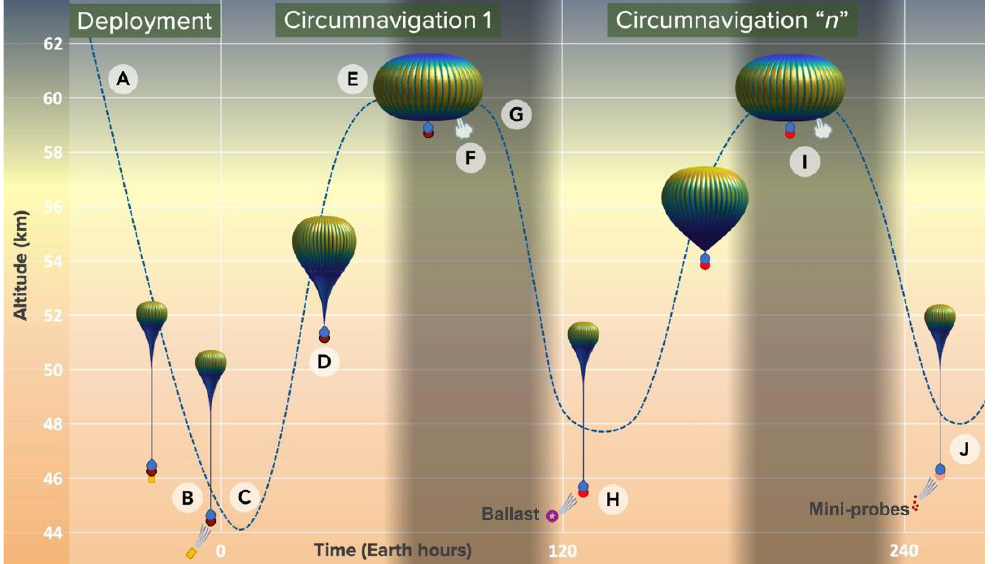
Figure 2. Balloon deployment and operation sequence for a variable altitude balloon, an alternative to the balloon mission shown in Figure 1. Not to scale. Figure from [33]. See main text of [33] for further details and the description of steps A - J .